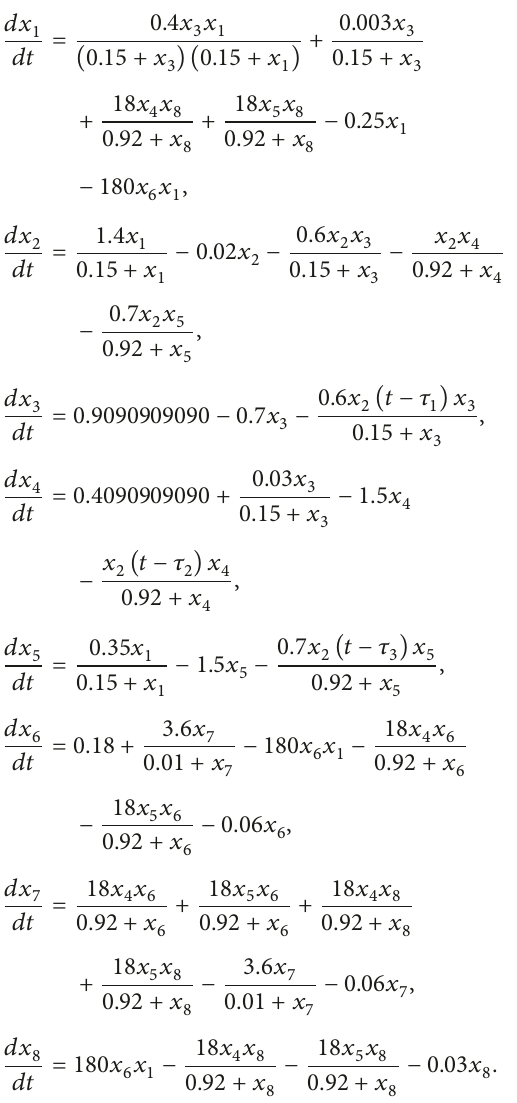
𝑥 = 1.2, 𝑥 1 = 0, 𝑥 = 0 , and 𝑆 = 5, 𝑘 7 8